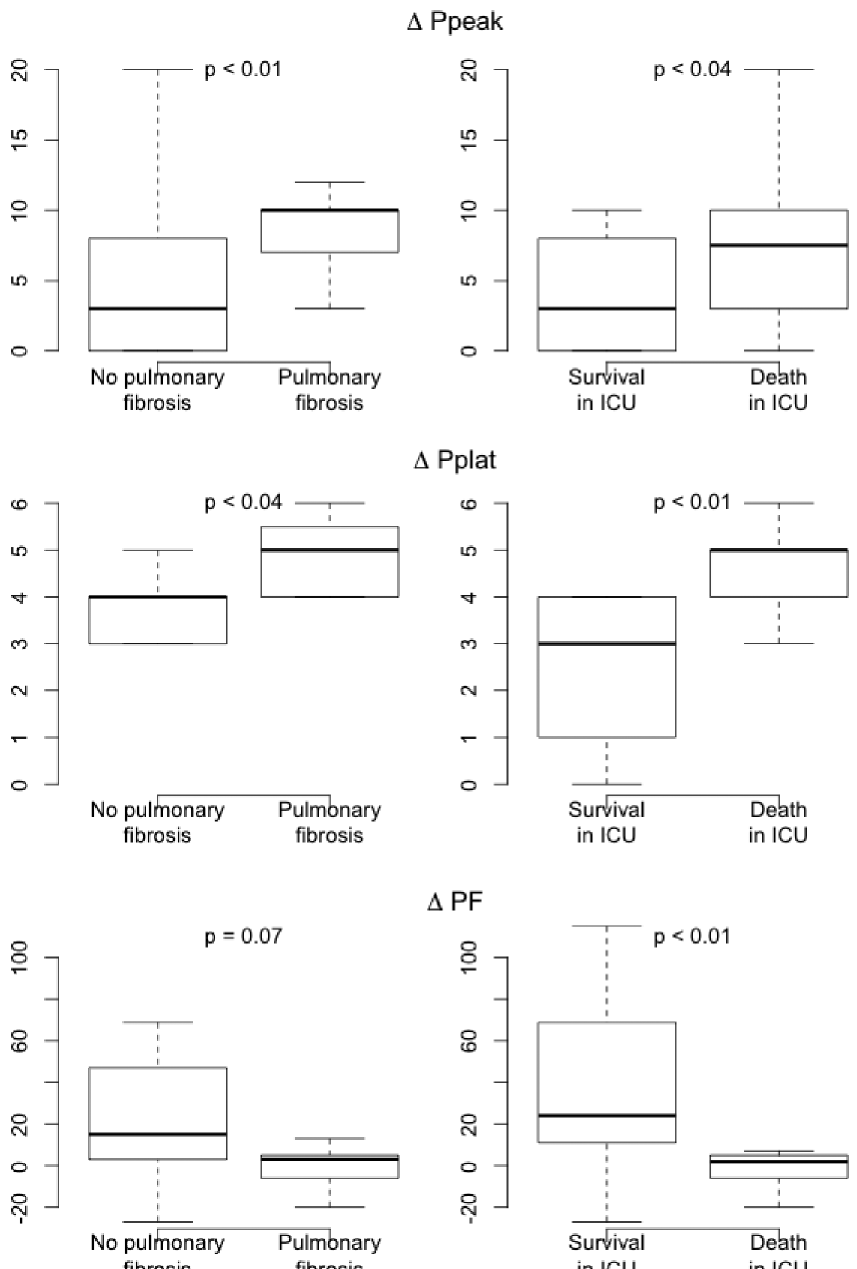
Figure 3. Effect of positive end-expiratory pressure (PEEP) titration in patients managed with invasive mechanical ventilation (n=50). Right column: correlations linking variations in peak airway pressure ( D Ppeak), plateau pressure ( D Pplat), and PaO 2 /FiO 2 ( D PF) before and after PEEP titration to ICU mortality. Left column: correlations linking variations in peak airway pressure ( D Ppeak), plateau pressure ( D Pplat), and PaO 2 /FiO 2 ( D PF) before and after PEEP titration to pulmonary fibrosis by computed tomography.